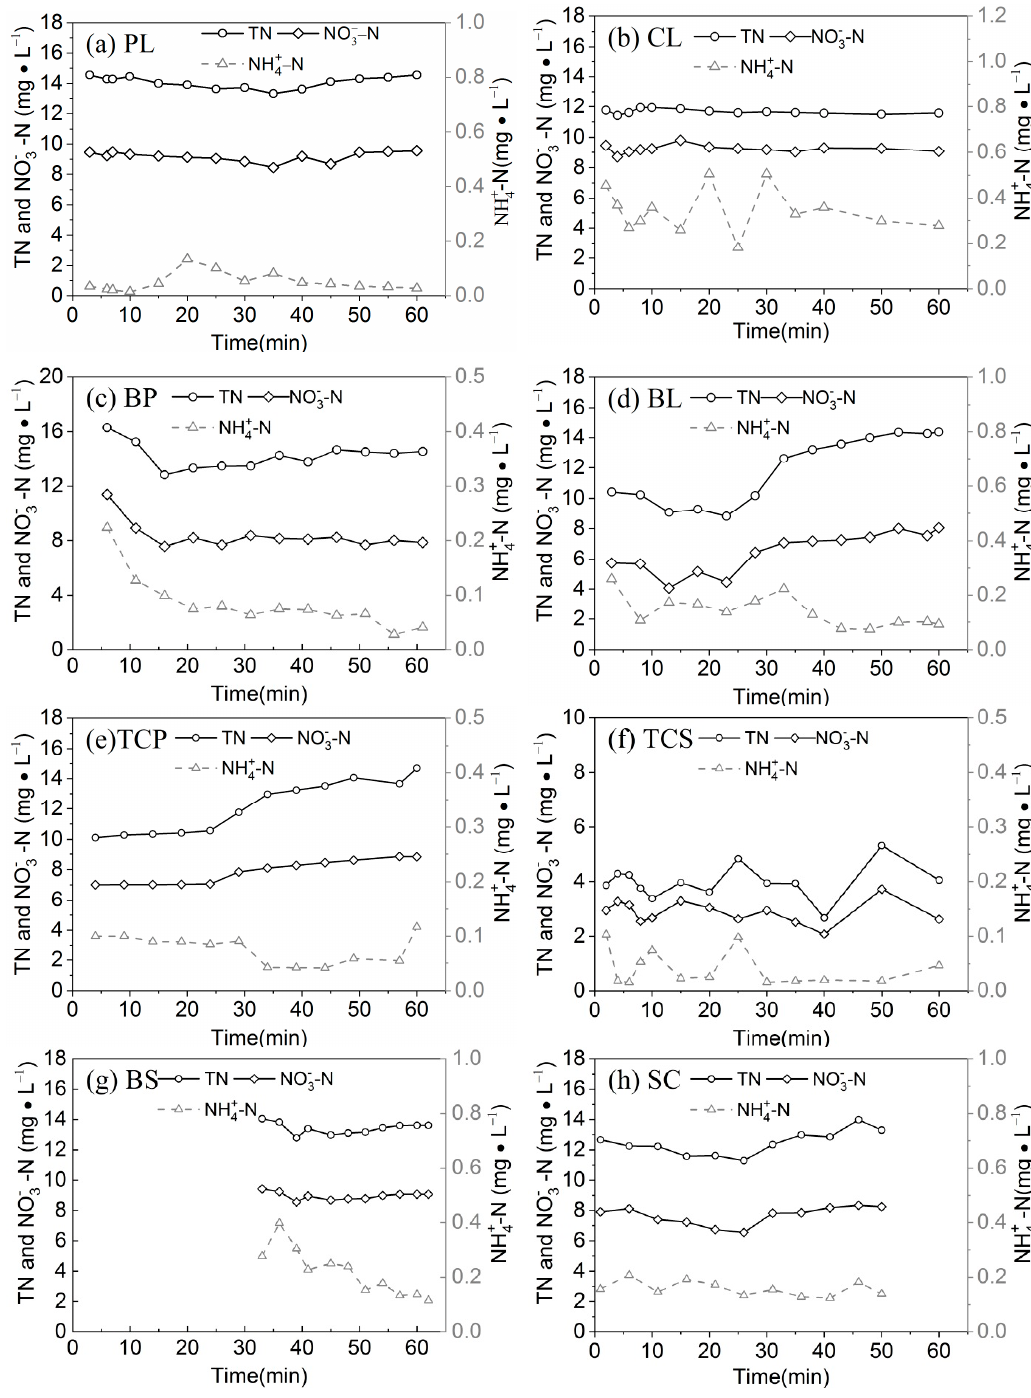
Figure 5. The variation of the TN, NO -